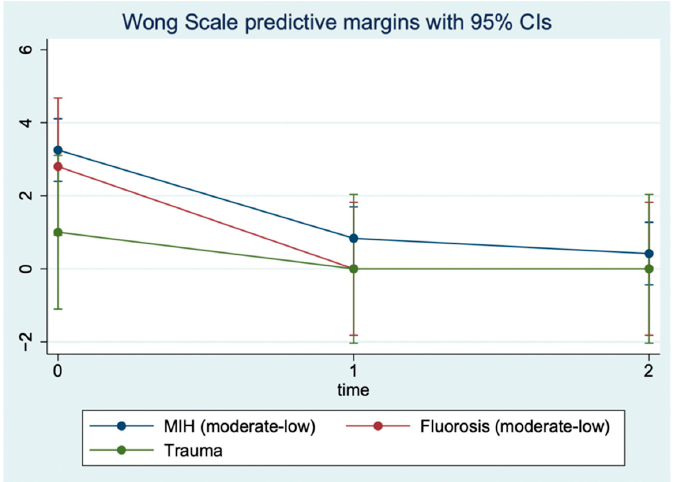
Figure 6. Wong–Baker Faces Pain Rating Scale levels predicted by repeated measures (three timepoints) restricted maximum likelihood mixed model.